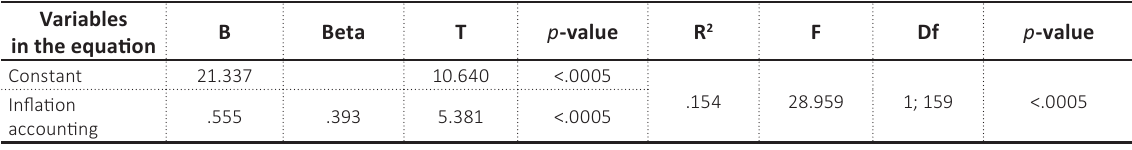
Table 10. Effects of inflation accounting on financial